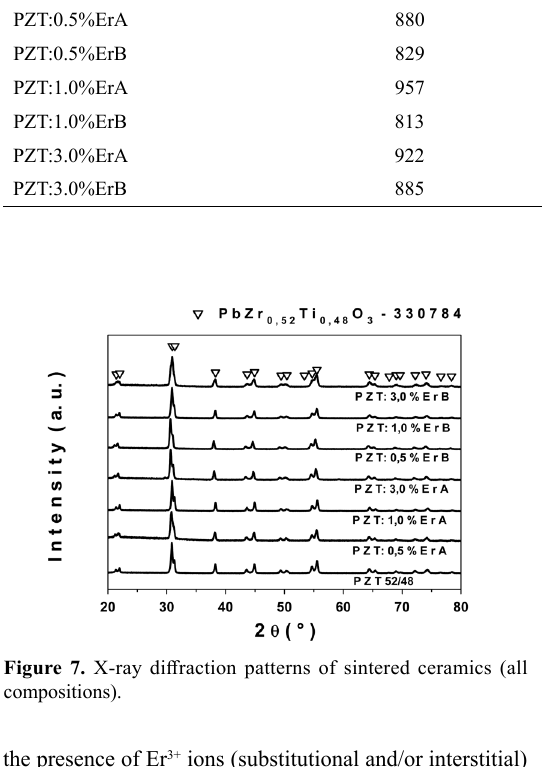
Figure 8. SEM image illustrating the microstructure of the undoped PZT52/48